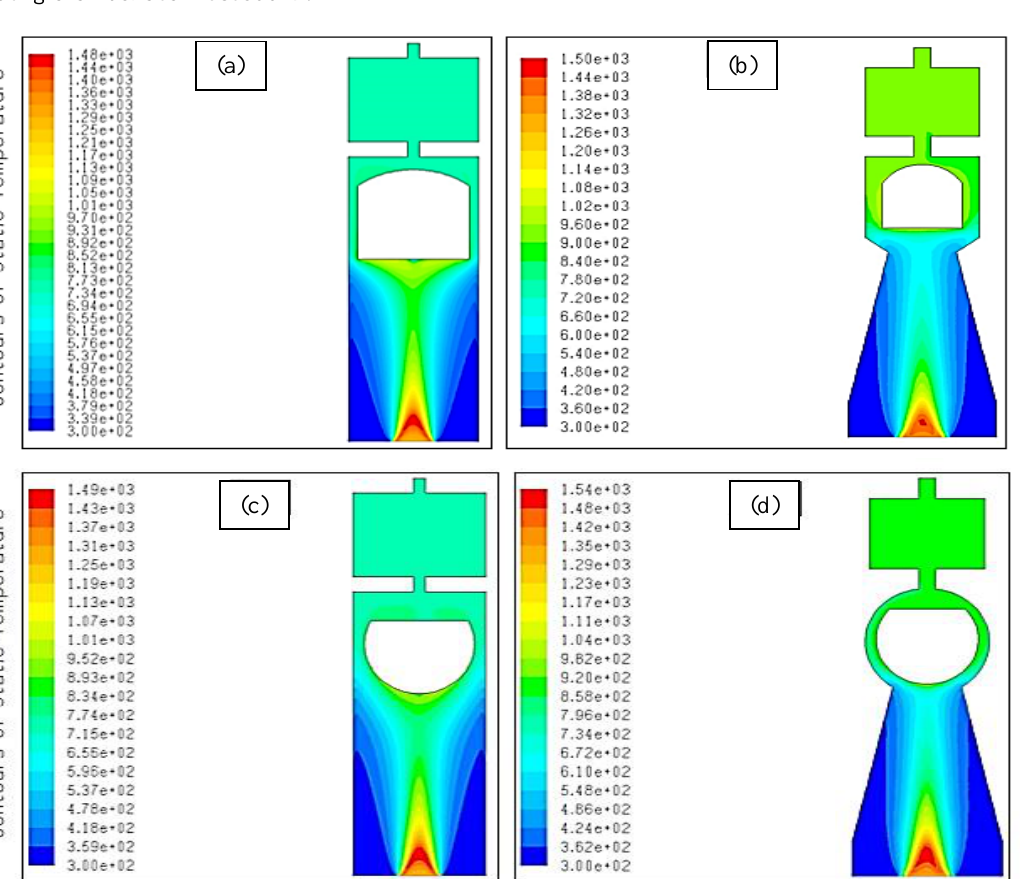
Figure 5. Contours of static temperature (K) for the four different modified